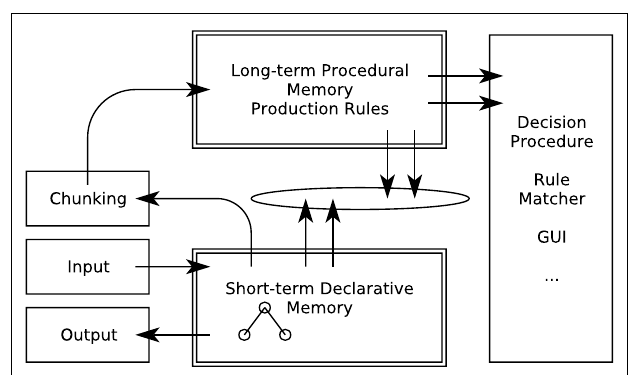
FIGURE 1 |The Soar information processing